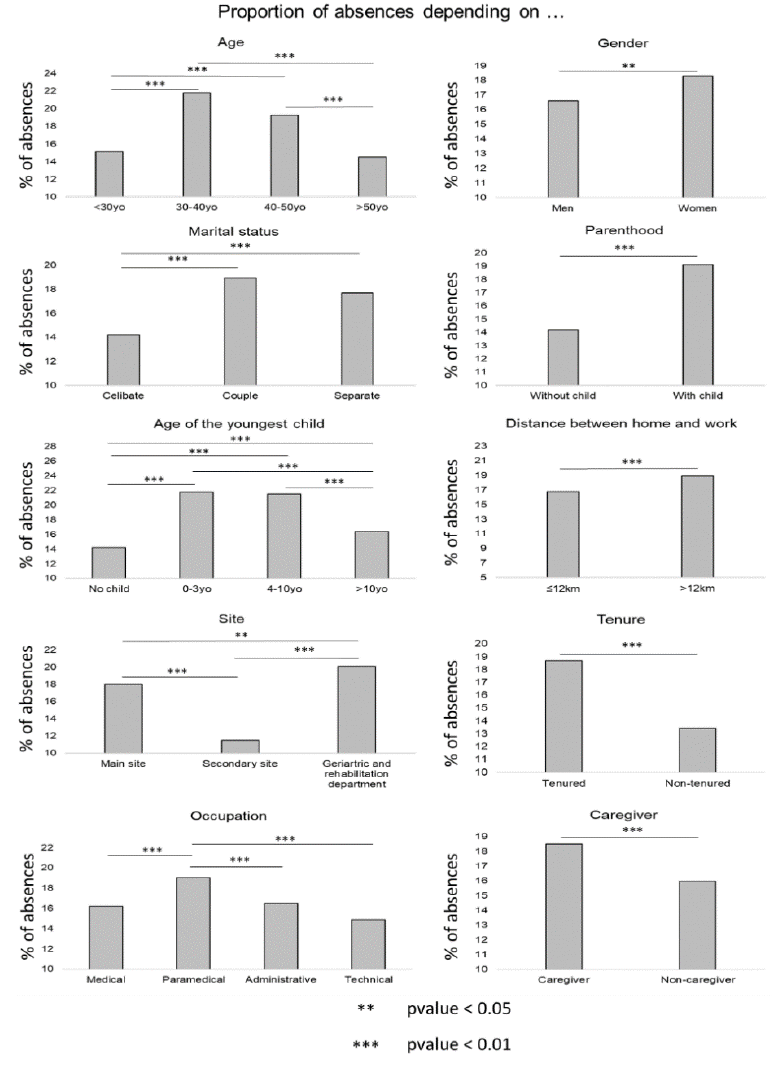
Figure 1. Proportion of absences depending on sociodemographic (age, gender, marital status, parenting, age of the youngest child, distance home/work) and professional variables (occupational groups, site, tenure, caregiver).